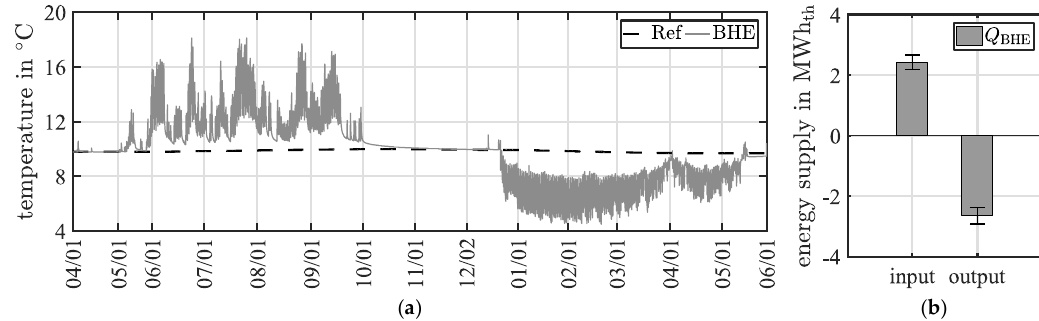
Figure 6. ( a ) Temperature profile of the grouting material for both borehole heat exchangers; ( b ) soil energy balance based on thermal energy input and output.